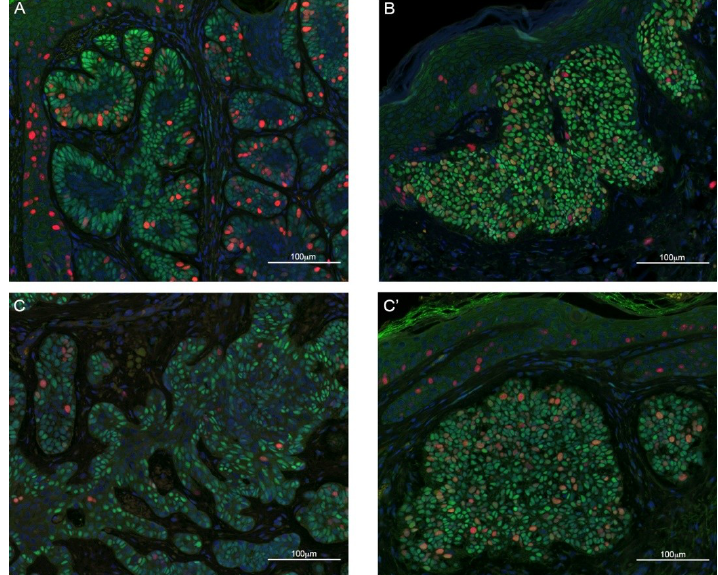
Figure 2. Examples of immunofluorescence staining of sections from skin biopsies of BCC with indolent growth. TBX1 in green, Ki67 (a cell proliferation marker) in red, and DAPI (DNA stain) in blue. ( A ) Example of polarized distribution of TBX1+ cells, defined as localization of positive cells at the periphery of the lesion (palisade cells), while internal cells are mostly TBX1‐negative; ( B ) example of diffuse distribution, defined as localization of positive cells to the entire lesion. ( C , C’ ) represent different regions of the same sample; note that both types of distribution, polarized ( C ), and diffuse ( C’ ) are present. Scale bar 100 μm. See Figure S1 for examples of hematoxylin‐eosin staining of these biopsies.